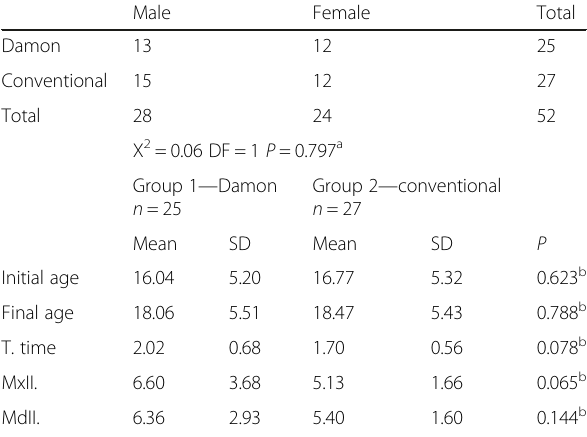
Table 3 Resorption scores found in groups 1 and